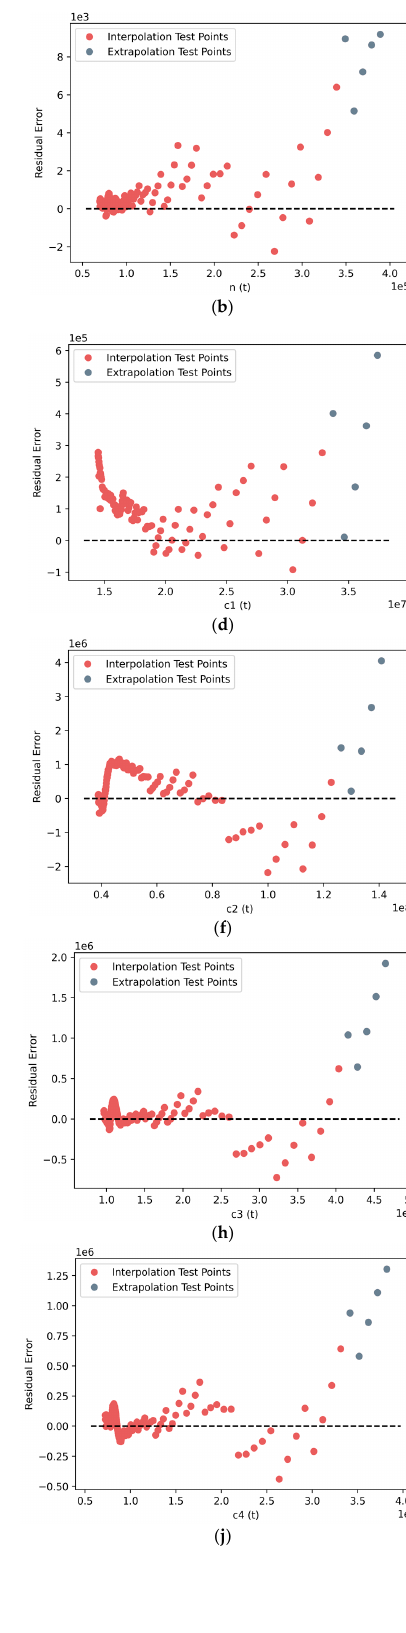
( b ) Figure 9. History of the loss function of PINN after 65,000 iterations for extrapolation. ( a ) The train- ing (blue) and testing (orange) loss is the summed-up MSE loss of all terms in the PKEs. ( b ) The test metric is the relative ℒ (cid:2870) error for the first ODE term. The results of the solution of the PKEs are shown in Figure 10. The left panels, Figure 10a,c,e,g,i,k,m, display PINN predictions along with reference solutions for neutron den- sity concentration, and six groups of delayed neutron precursor density concentrations, respectively. As can be seen from the figures, PINN predictions closely approach the ref- erence solution for both the computational domain of interpolation, 𝑡 ∈ (cid:4670)0,207(cid:4671)𝑠 , and ex- trapolation, 𝑡 ∈ (cid:4670)208,217(cid:4671)𝑠 . More specifically, in the time interval of 𝑡 ∈ (cid:4670)208,217(cid:4671)𝑠 , the predictions seem to experience their lowest accuracy in the final second of the solution, whereas they maintain high accuracy in the rest time interval, even comparable to the interpolation case. Similar to before, the stiffness of the PKE system does not prevent the PINN from capturing the basic dynamics of the system. The right panels, Figure 10b,d,f,h,j,l,n, display the residual errors of neutron density concentration and delayed neutron precursor density concentrations for six groups, re- spectively. The testing points used for interpolation are shown in red, and the testing points used for extrapolation are shown in gray. In every case, the largest error in extrap- olation is greater than the largest error in interpolation. However, in most cases, the errors in extrapolation are comparable to errors in interpolation. Therefore, based on cases con- sidered in the study, the PINN’s capacity to perform extrapolation is reasonably good compared to the interpolation capability.